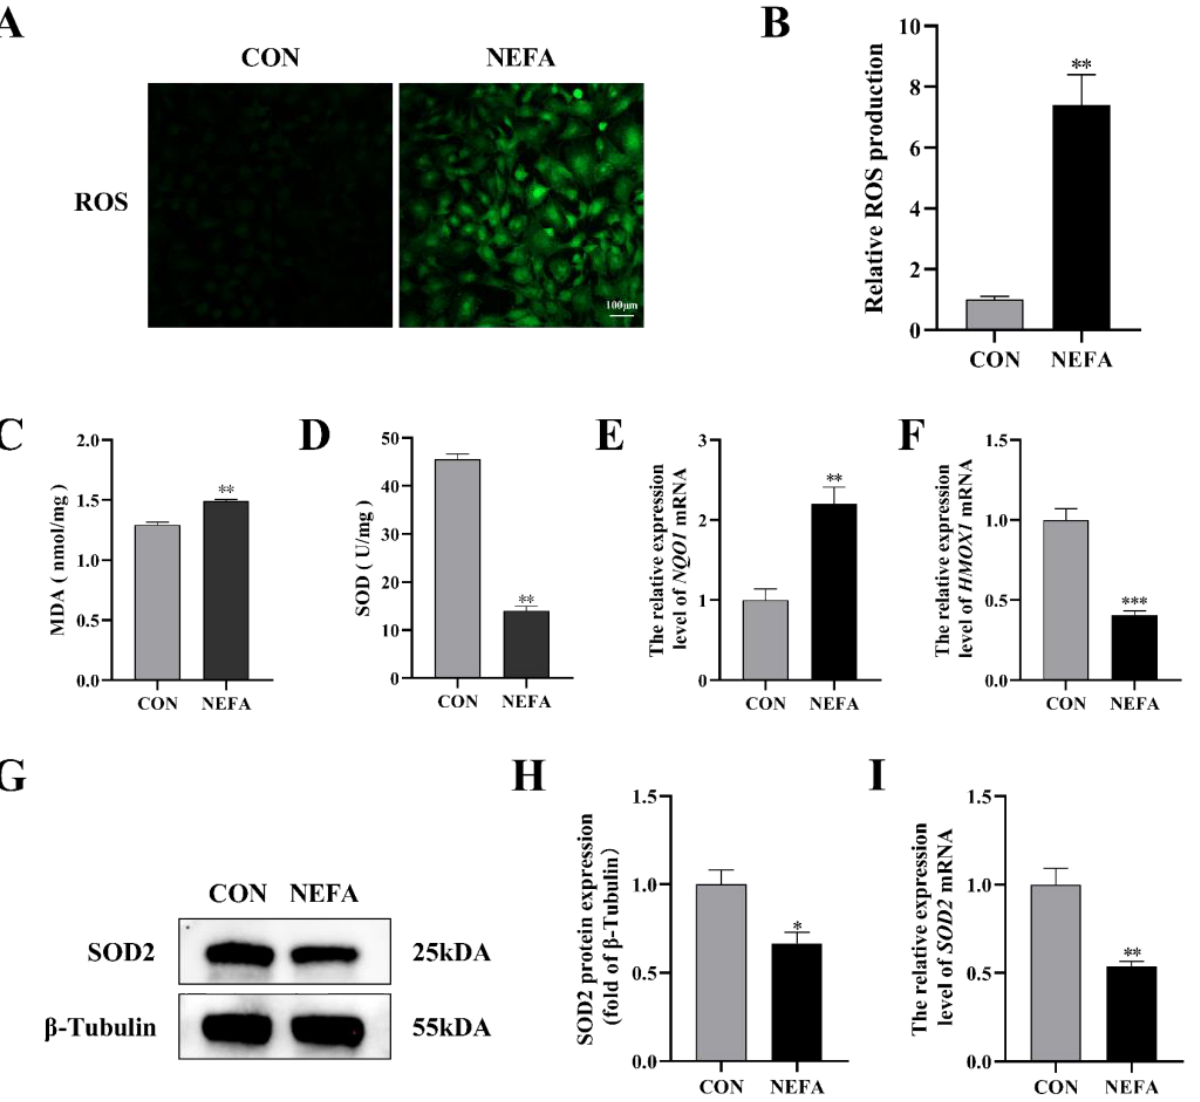
Figure 2. Effects of NEFA on ROS generation and oxidative stress in BGCs. BGCs were treated with or without 1.2 mM NEFA for 24 h. ( A , B ) Fluorescent microscopic images of ROS generation by using DCFH − DA staining and comparison of Relative fluorescence intensity between control and NEFA − treated. Green: DCFH − DA, scale bar: 100 µ m. ( C , D ) The cellular MDA and SOD content was tested by Kits. ( E , F ) The mRNA levels of NQO1 and HMOX − 1 were determined using qRT − PCR. ( G – I ) SOD2 protein and gene expression in BGCs. The quantification of the relative protein levels (performed using Image J) is shown under the band (protein/ β − Tubulin). This experiment was repeated 3 times, and data are expressed as mean ± standard errors of the mean (SEM), * p < 0.05; ** p < 0.01; *** p < 0.001; ns, not significant.